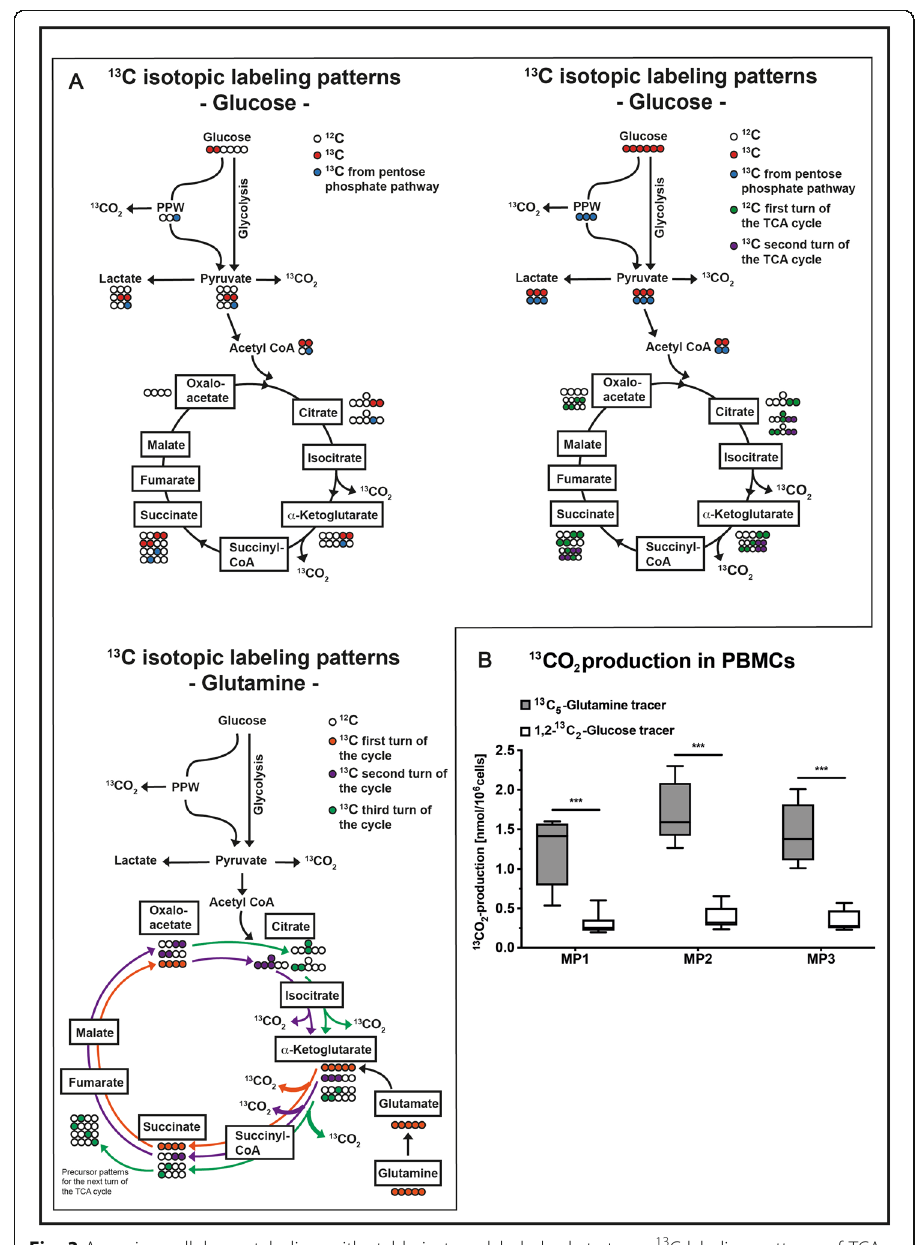
Fig. 3 Assessing cellular metabolism with stable isotope-labeled substrates. a 13 C labeling patterns of TCA cycle metabolites resulting from utilization of 1,2- 13 C 2 -glucose (upper left), 13 C 6 -glucose (upper right), and 13 C 5 -glutamine (lower left). Depending on the substrate used, further conclusions can be drawn on the involvement of the PPP or the cycling within the TCA cycle. b 13 CO 2 production in PBMCs from a porcine model of acute subdural hematoma at MP before (MP1), 12 h (MP2), and 24 h (MP3) after hematoma induction. 5 × 10 6 PBMCs/mL were incubated in chemically identical RPMI media containing either 1,2- 13 C 2 -glucose, 13 C 6 -glucose, or 13 C 5 -glutamine. Supernatant was transferred to airtight vials and acidified to release CO 2 into the gas phase where 13 CO 2 enrichment was determined by gas chromatography-mass spectrometry. Data are presented as median and interquartile range; *** p < 0.0001 according to a 2-way ANOVA and a Sidak ’ s multiple comparisons test, n = 5 – 6. Abbreviations: CO 2 , carbon dioxide; MP, measurement timepoint; PBMCs, peripheral blood mononuclear cells; PPP, pentose phosphate pathway; TCA, tricarboxylic acid